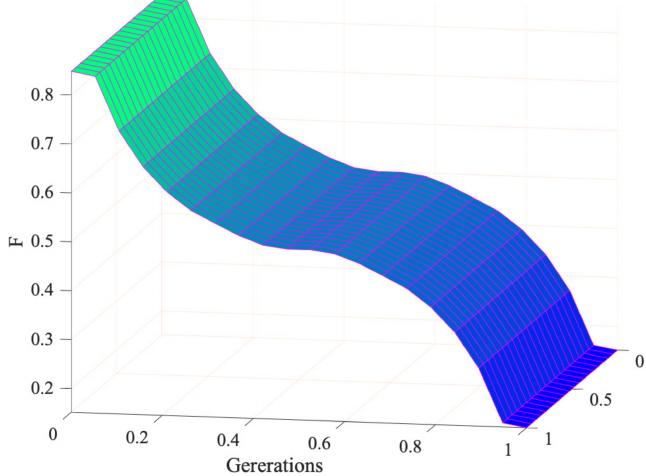
Figure 3. The surface of the IT3FDE